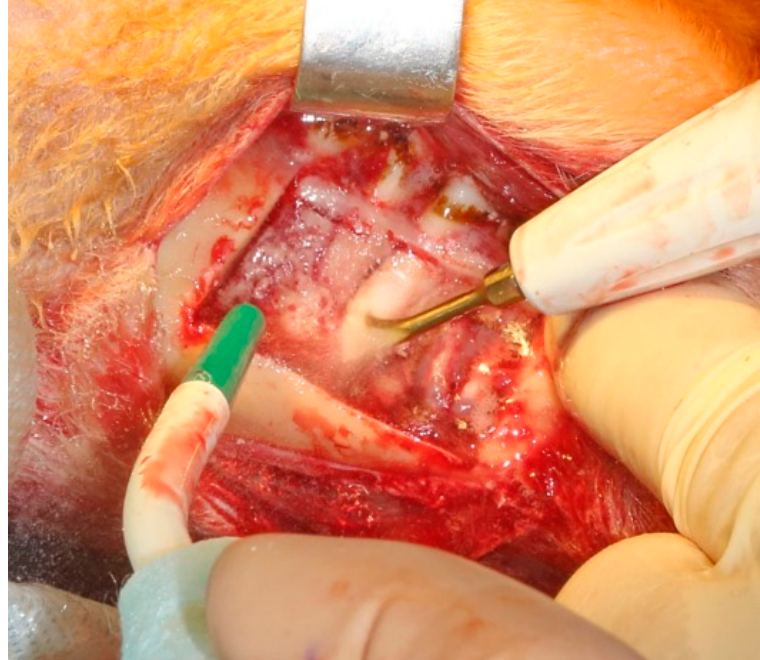
Figure 3. Surgical preparation of implant recipient zone in the mandible.